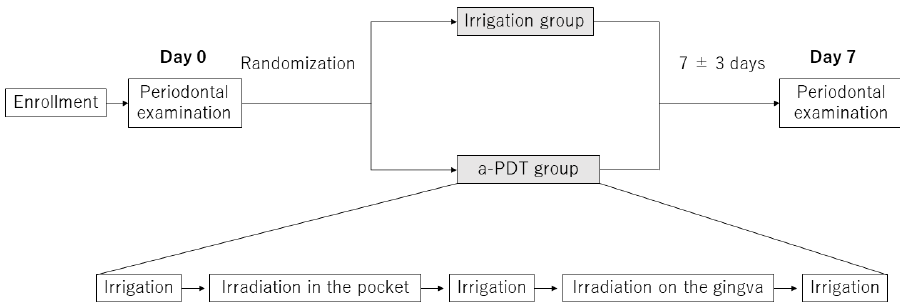
Figure 1. Study design. An ultrasonic scaler was used for irrigation.